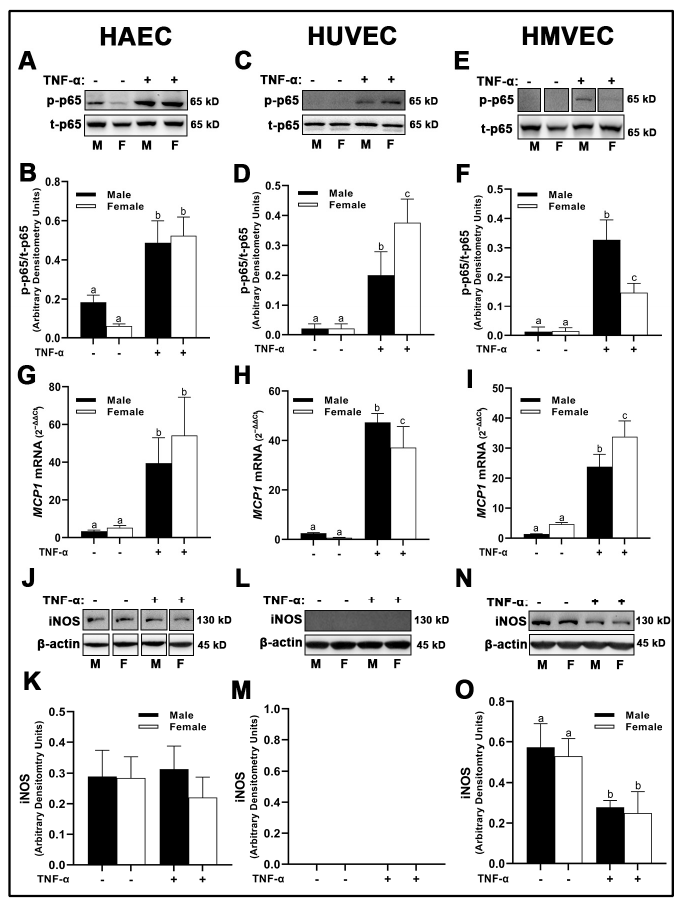
Figure 11. Expression of inflammatory markers in male and female endothelial cells. HAECs, HUVECs and HMVECs were cultured in starvation medium at ~80% confluency for 24 h with